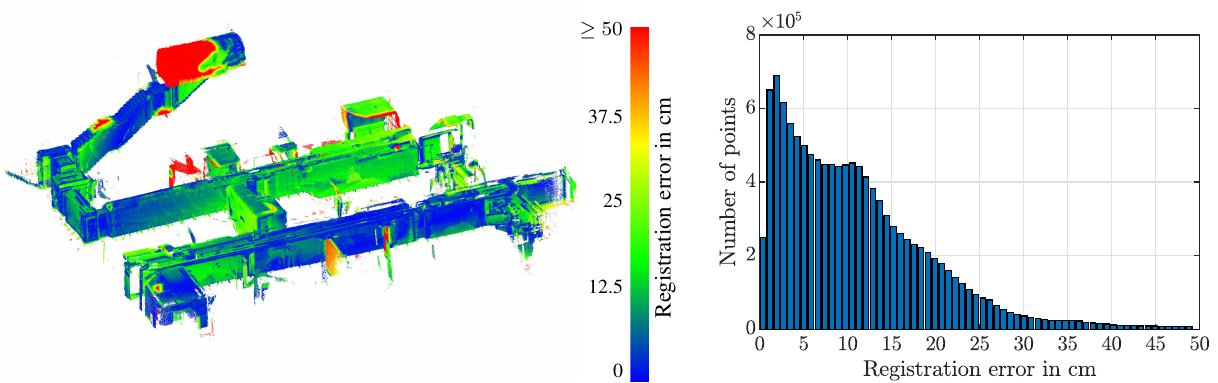
Figure 8. Comparison of the backpack point cloud with reference scans of the bunker created using a Riegl VZ-400 laser scanner. Left: Point cloud colored by the registration error. Right: Error histogram. Errors larger than 50 cm are removed since they are assumed to only occur in regions without any overlap between the two point